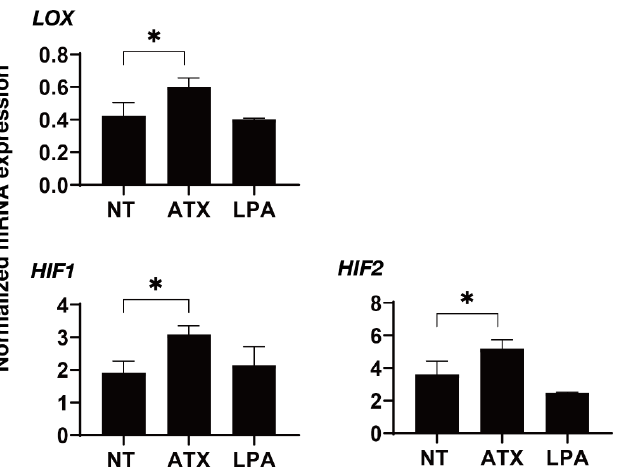
Figure 6. mRNA expression of LOX and HIFs in 3D cultured HTM cells. During the 6-day culture of the 3D HTM spheroids, 2 mg/L ATX or 200 nM LPA was exposed during Day 5 through 6, and the mRNA expression of LOX , and HIF1 and 2 were measured. All experiments were performed in duplicate using fresh preparations. NT; untreated control. Data are presented as the arithmetic mean ± standard error of the mean (SEM). * p < 0.05, ( ANOVA followed by Tukey’s multiple comparison test). LOX; lysyl oxidase, HIF; hypoxia inducible factor.